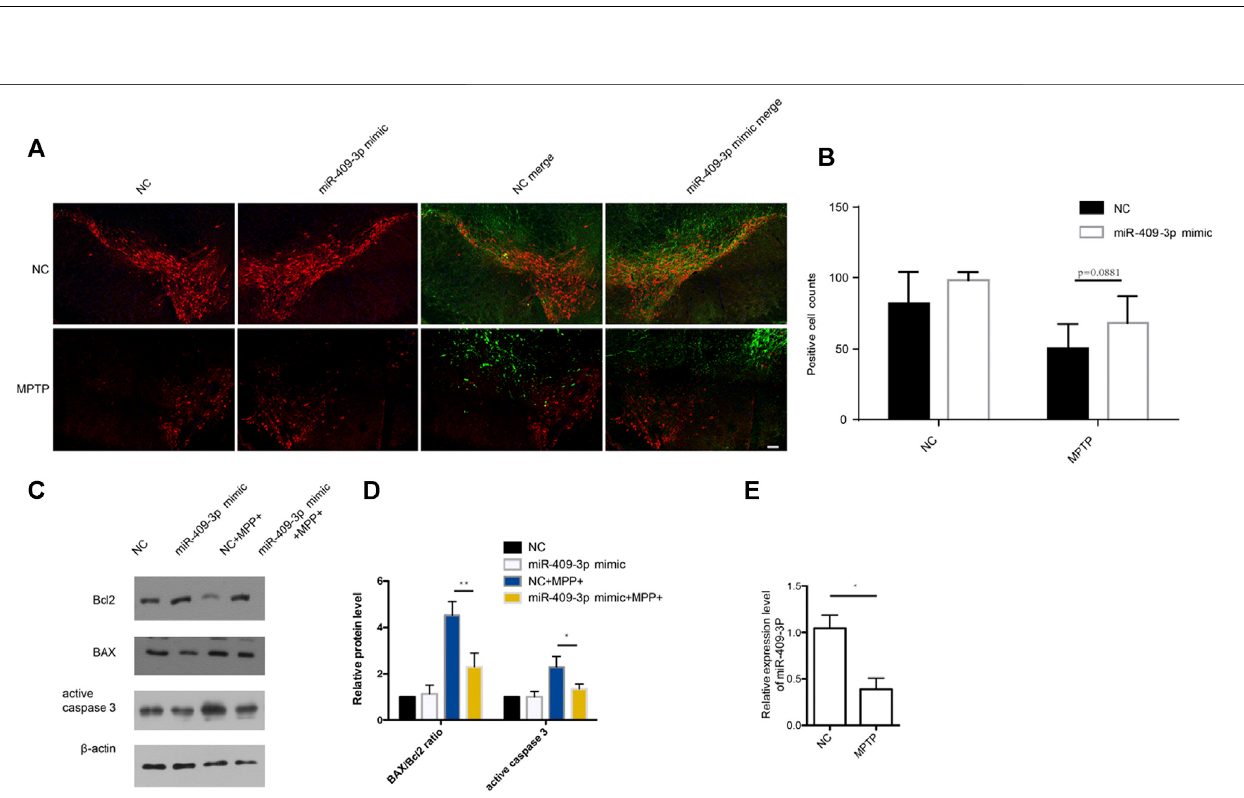
FIGURE 5 | miR-409-3p overexpression protects loss of TH neurons induced by MPTP in vivo . (A) TH positive neurons (red) and miR-409-3p overexpression (green)inSNcweredetected byimmuno fl uorescenceanalysis.ThemicewereinjectedAAVcarriedwithmiR-409-3pcontrolandmimicontheleftandrightsidesoftheir brains. TH neuron numbers decrease after MPTP treatment. Scale bar (cid:2) 50 μ m. (B) Histograms used to count the number of TH cells shows a relatively amount of TH positive neurons at right side compared to control side. (C) The apoptosis related proteins (BAX, Bcl2 and Cleaved caspase 3) were detected by western blot analysisinSNc. (D) HistogramsshowsthattheBAX/Bcl2ratioandthelevelofactivecaspase3decreaseinthemiR-409-3poverexpressiongroupwithMPTPtreatment. Student t -test, * p < 0.05; ** p < 0.01. (E) . The expression of mouse miR-409-3p was detected by real-time PCR. Data were analyzed using Student t -test, *, p < 0.05.